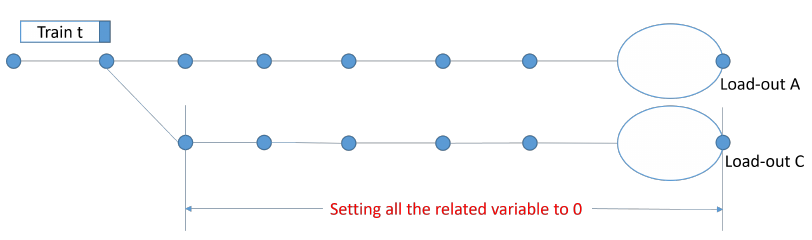
Figure 3. Preprocessing sample 1.